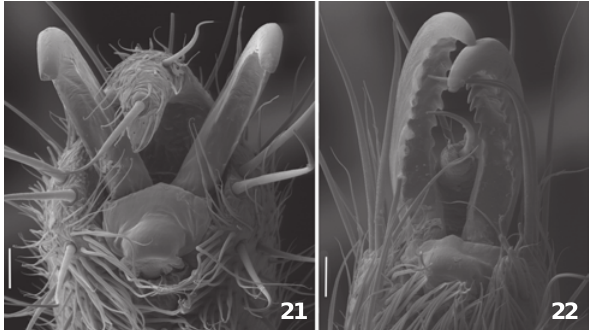
Figures 21-22. Claws of tarsus IV of Parampheres , ventral view: (21) P. bimaculatus , MCNRS0726; (22) P. pectinatus , MCNRS18204. Scale bars: 0.05 mm.